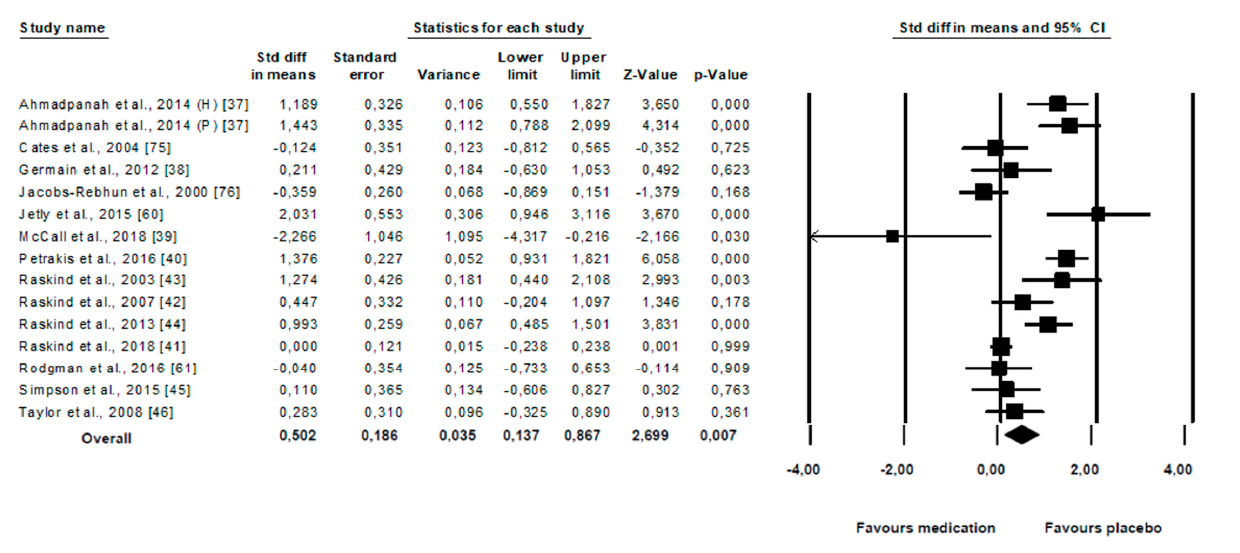
Figure 2. Forrest plot [37–46,60,61,75,76].